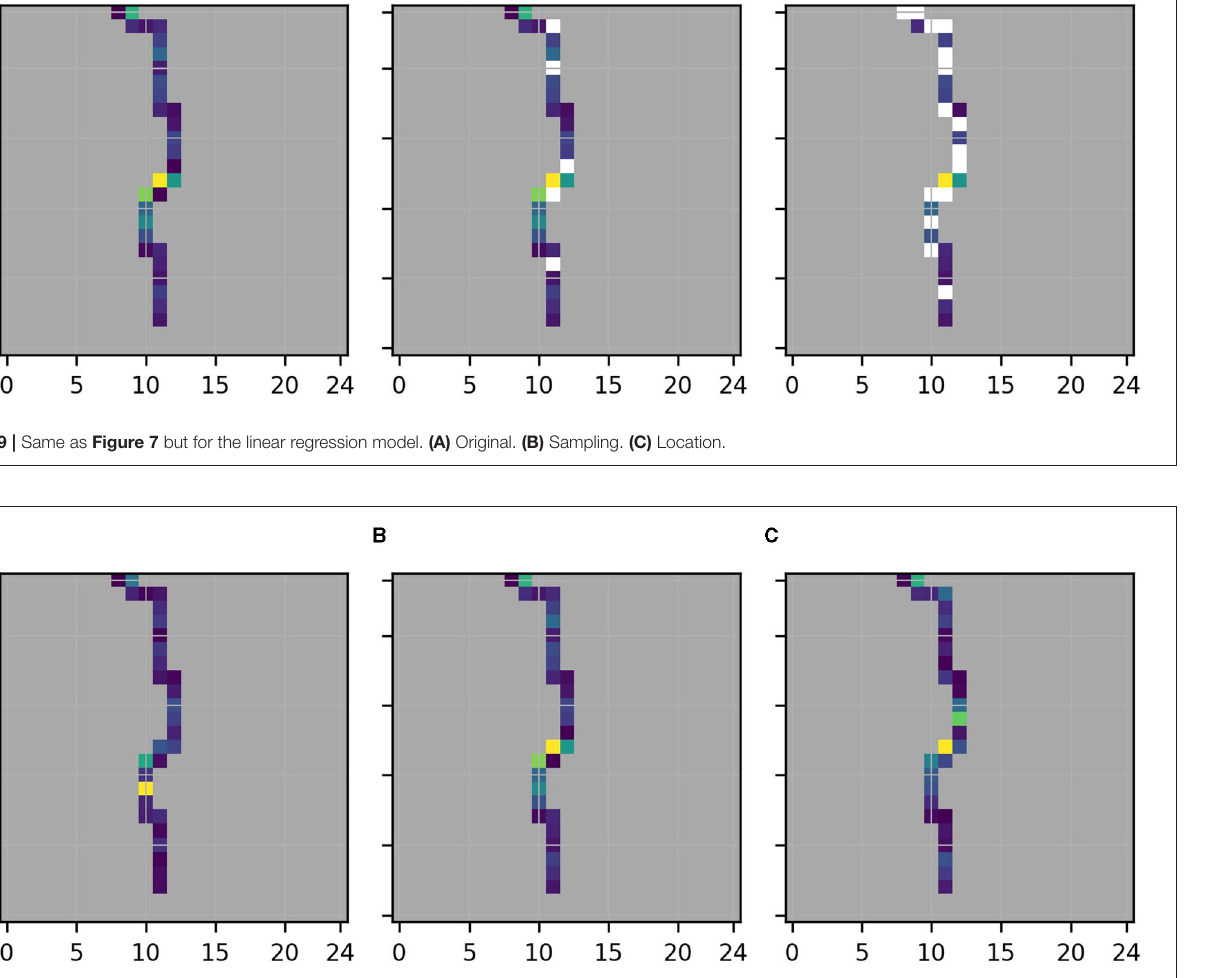
FIGURE 10 | Same as Figure 8 but for the linear regression model. (A) Lower target location. (B) Central target location. (C) Upper target